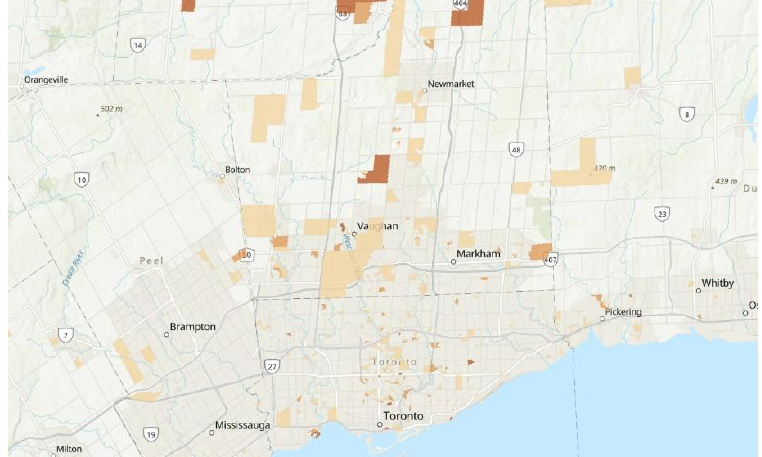
Figure 3. Average Delay Time of examinations between the height of the COVID – 19 pandemic period (period 2) and beginning of vaccinations period (period 3) per Dissemination Area. A map of Greater Toronto Area, Ontario, Canada with patients aggregated by dissemination area and average delay time (days) calculated for each dissemination area was produced by ArcGIS online. Dissemination areas of patients are marked by a gradient based on delay time. The darkest orange shows a delay in examination >180 days while the lightest orange shows a delay in examination <90 days. Dissemination areas with no color have no patient data .